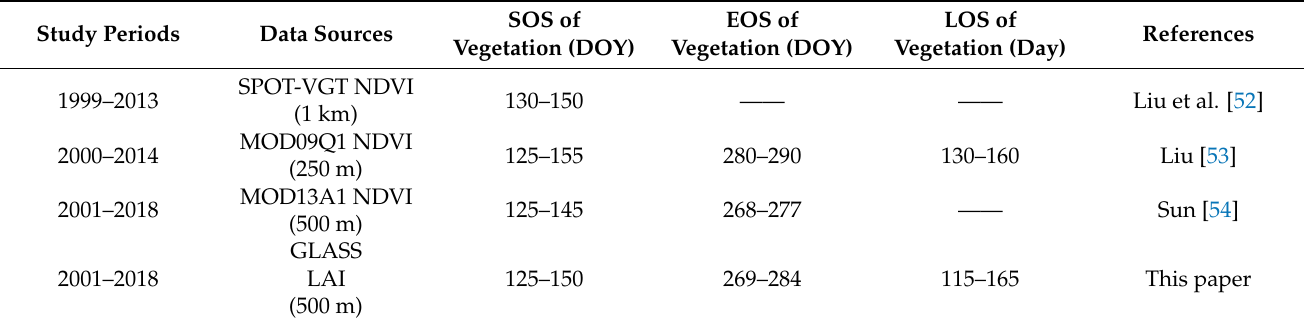
Table 5. Comparisons between this study and previous